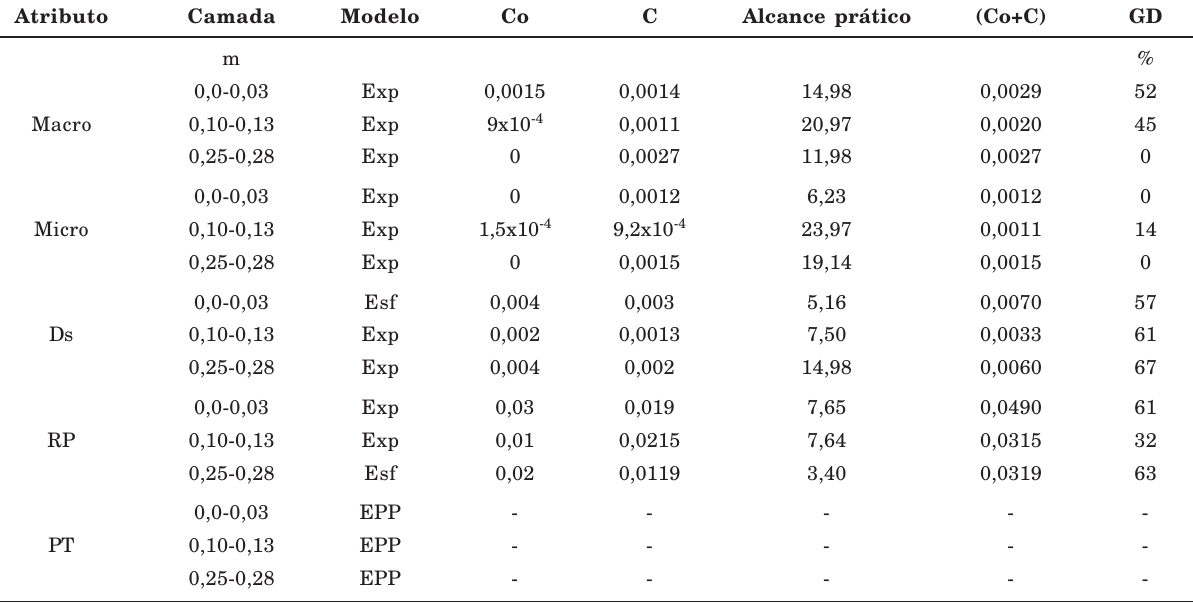
(Figura 4), observou-se a predominância de valores para a Micro na faixa de 0,45 m 3 m -3 ou superior em quase a totalidade da área (tonalidade rosa). A camada de 0,10-0,13 m apresentou valores de Micro do solo de 0,45 m 3 m -3 (tonalidade amarela) e menores que específicas no